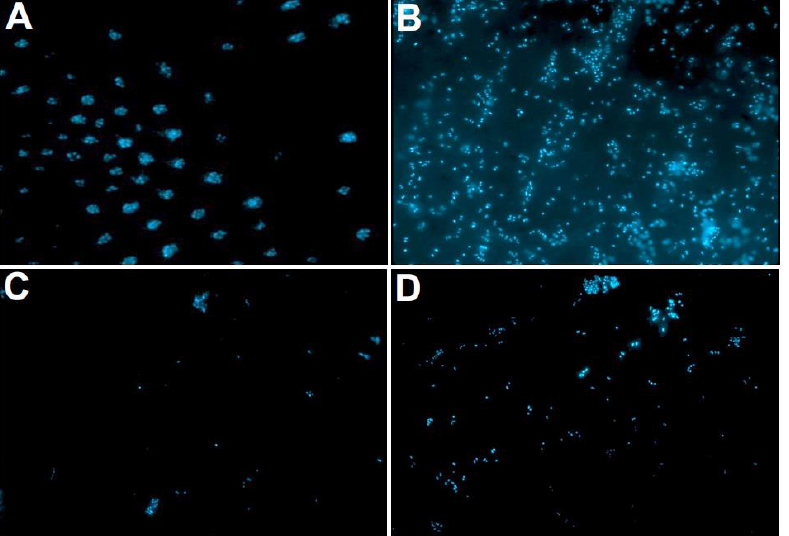
Figure 3. The fluorescence microscopy images after DAPI staining. The initial microbial adhesion (2 h) is depicted on bovine dentin (control) ( A ), MTA ( B ), Biodentine ( C ), and AH Plus ( D ).